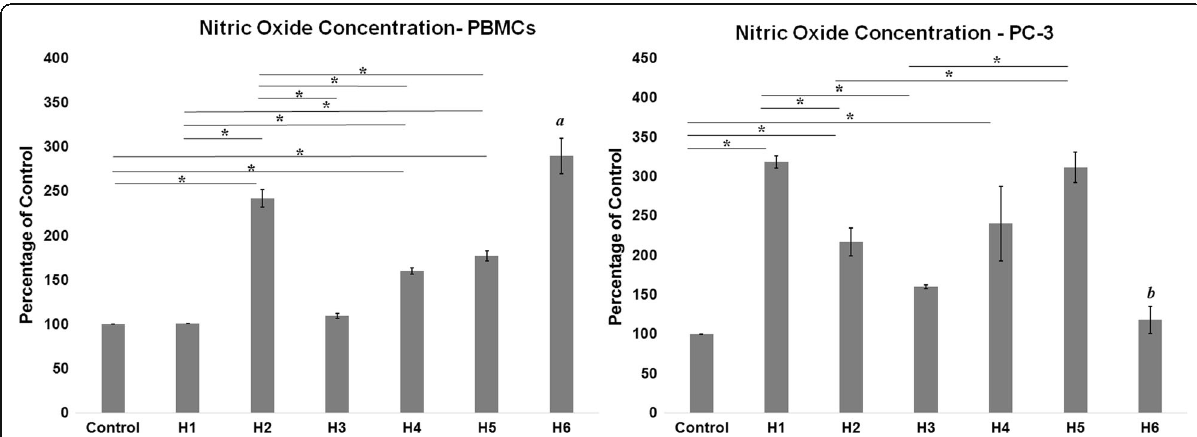
Fig. 2 Nitric oxide concentration after 24-h incubation with honey varieties. Data expressed as percentage of control. *Significant difference in NO levels observed between groups. a - Significant increase of NO levels in H6 treated groups in comparison to all honey varieties and control in PBMCs. b - Significant lowering of NO level in H6 treated groups in comparison to H1, H2, H4, and H5 in